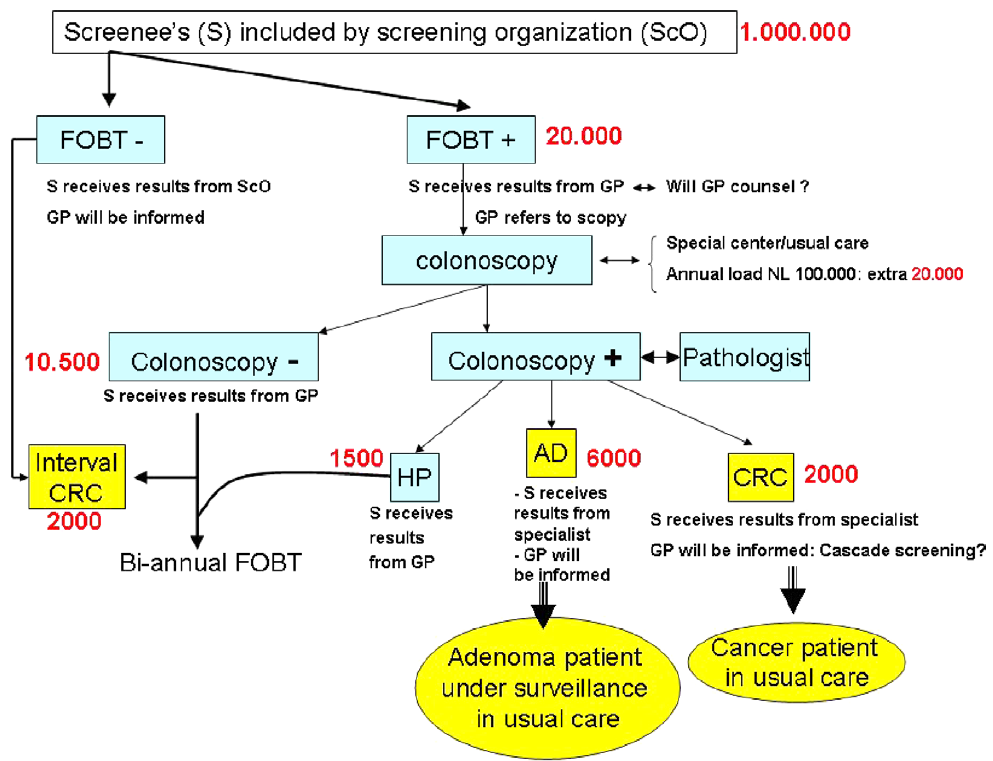
Fig. 2. Concept flow chart. Abbreviations in the figure: ScO = screening organisation; GP = general practitioner; S = screening individual; HP = hyperplastic polyp; CRC = colorectal cancer; AD =